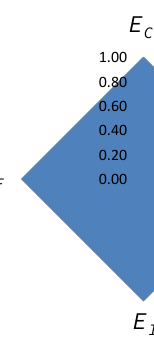
Figure 2. Radar chart showing the score of a different perspective along each of the four semiaxes in the fully efficient case with E C = E IP = E I = E F = 1.